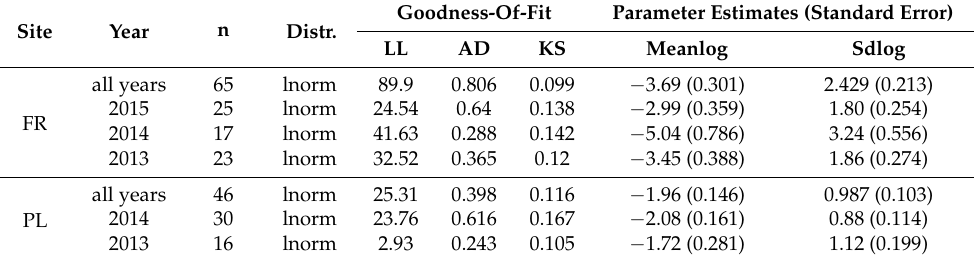
Table 5. Results of fitting empirical TSS load distribution functions grouped by year to lognormal distribution function (FR: Flat Roof, PL: Parking Lot, LL: LogLikelihood, AD: Anderson-Darling statistic A 2 , KS: Kolmogorov-Smirnov statistic D n